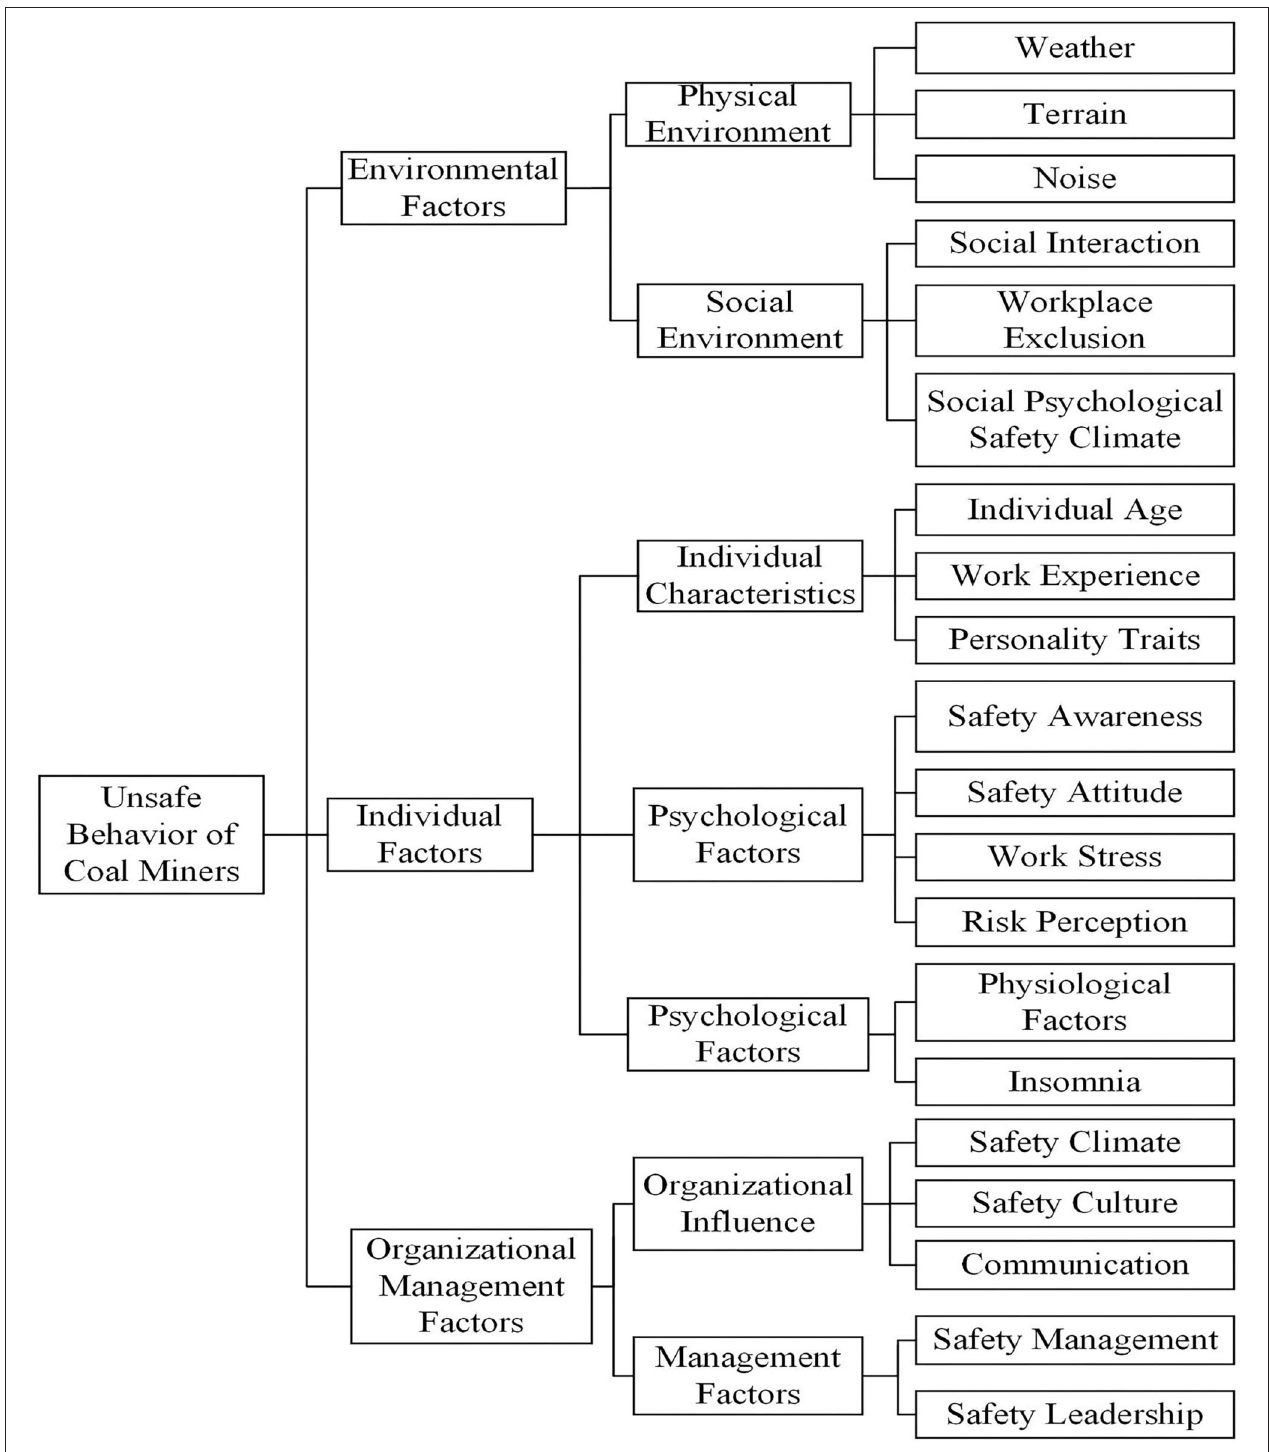
FIGURE 6 | The index system framework of influencing factors of coal mine workers’ unsafe behavior.